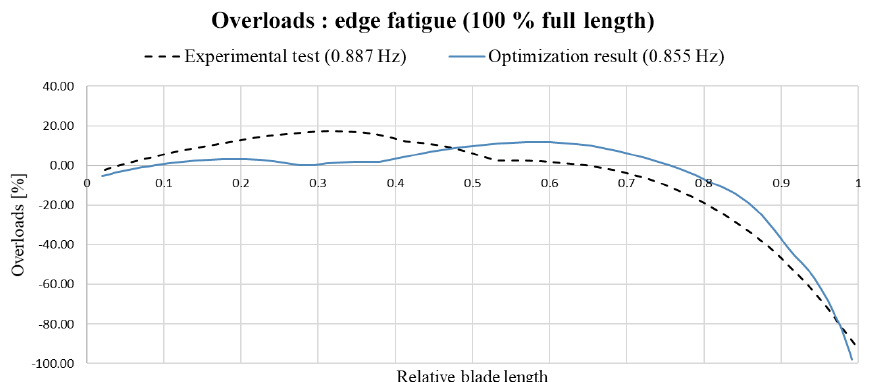
Figure 3. Overload distribution from the full-scale lead-lag fatigue test of the 60m